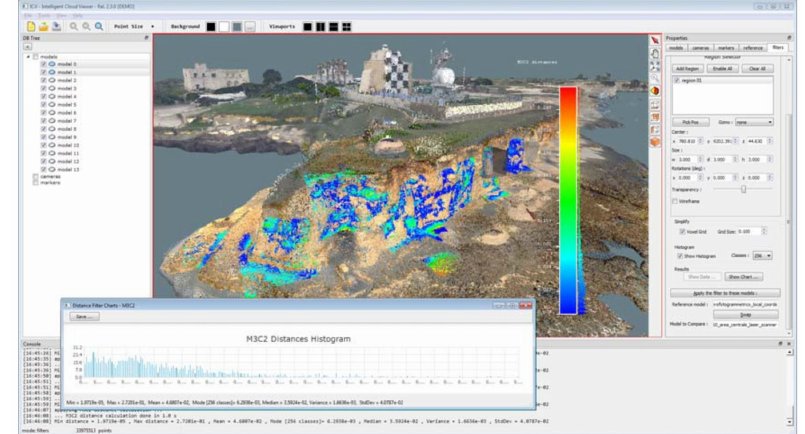
Figure 19. Results of M3C2 application.